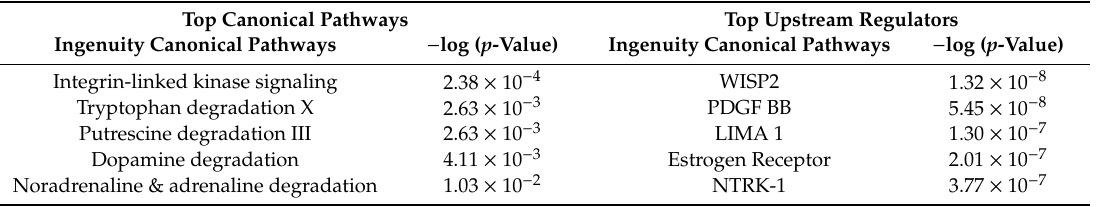
Table 2. Ingenuity Pathway